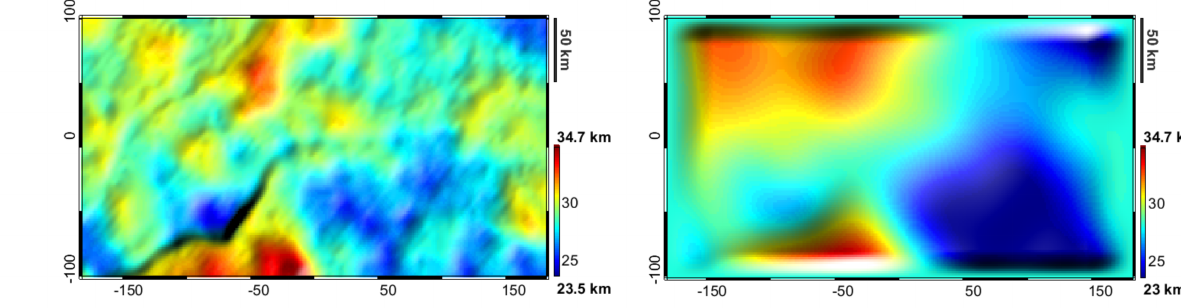
Figure 5. Two-layer problem inversion: Moho estimated by the Bayesian inversion ( left ) and from classical Parker– Oldenburg inversion ( right